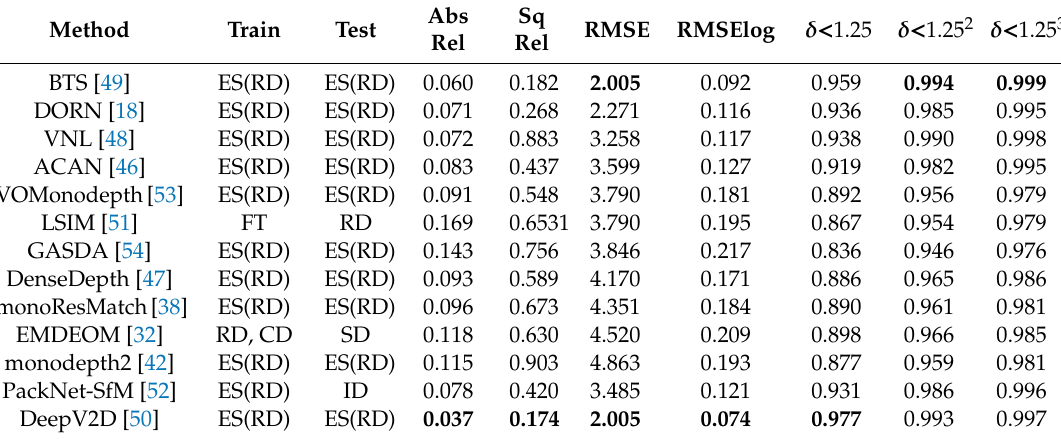
Table 4. Evaluation results on KITTI dataset. Best method per metric is emboldened and highlighted in green. (RD: KITTI Raw Depth [31]; CD: KITTI Continuous Depth [31,32]; SD: KITTI Semi-Dense